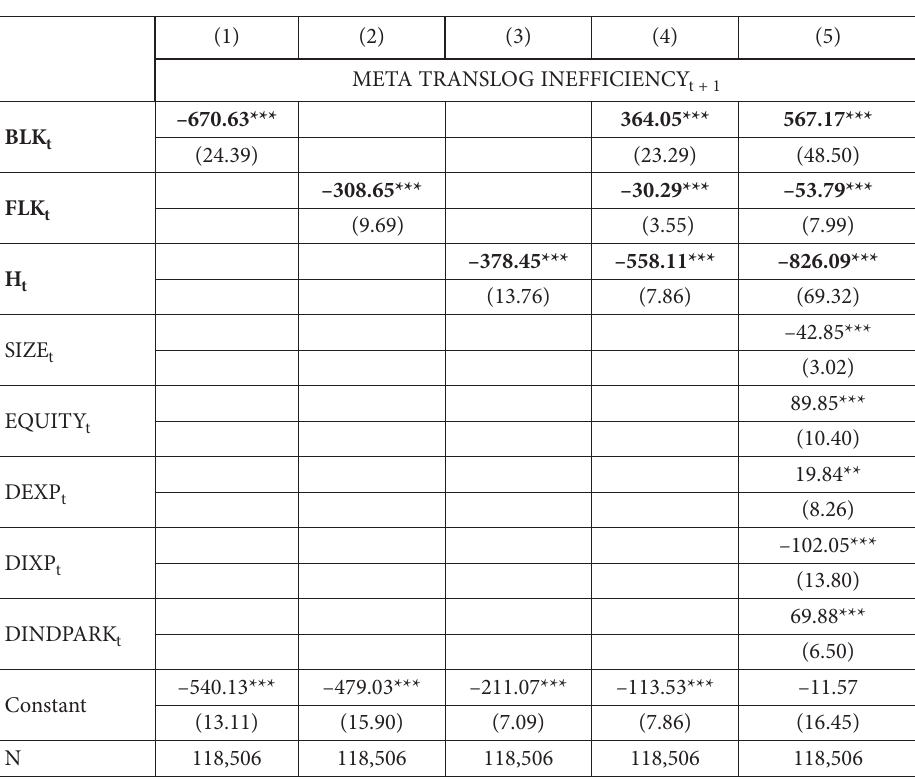
Table 4. Baseline regression